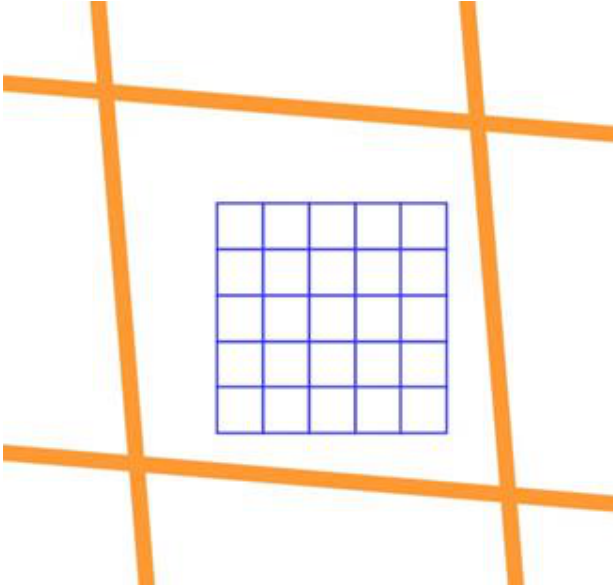
Figure 6. Medium resolution satellite image pixels (orange) and hyperspatial sUAS image pixels (blue) prior to reprojection.